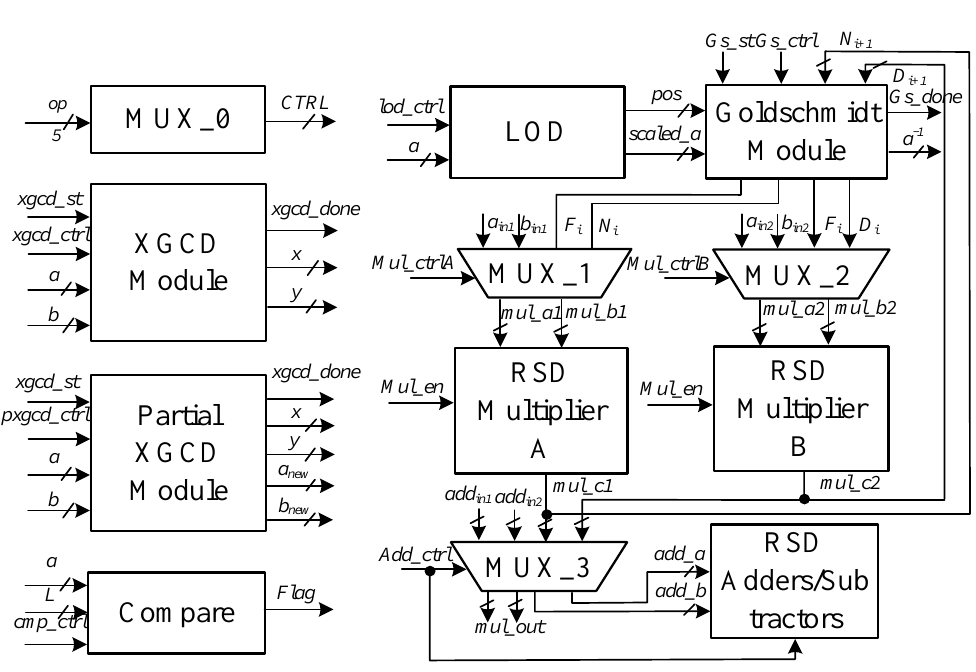
Figure 12: Proposed calculation modules in the computation